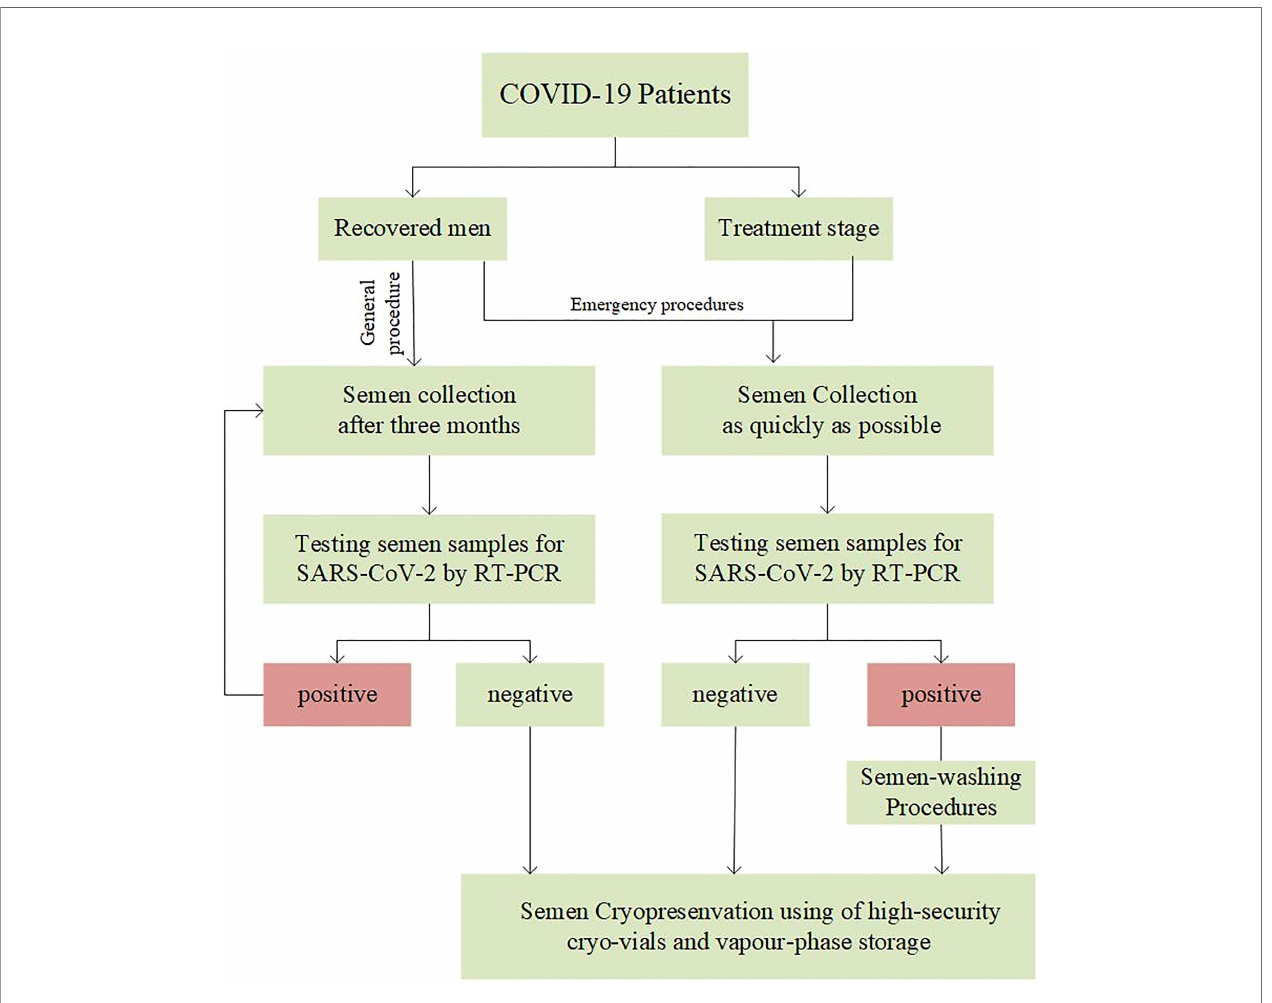
FIGURE 1 | A decision path for sperm cryopreservation of COVID-19